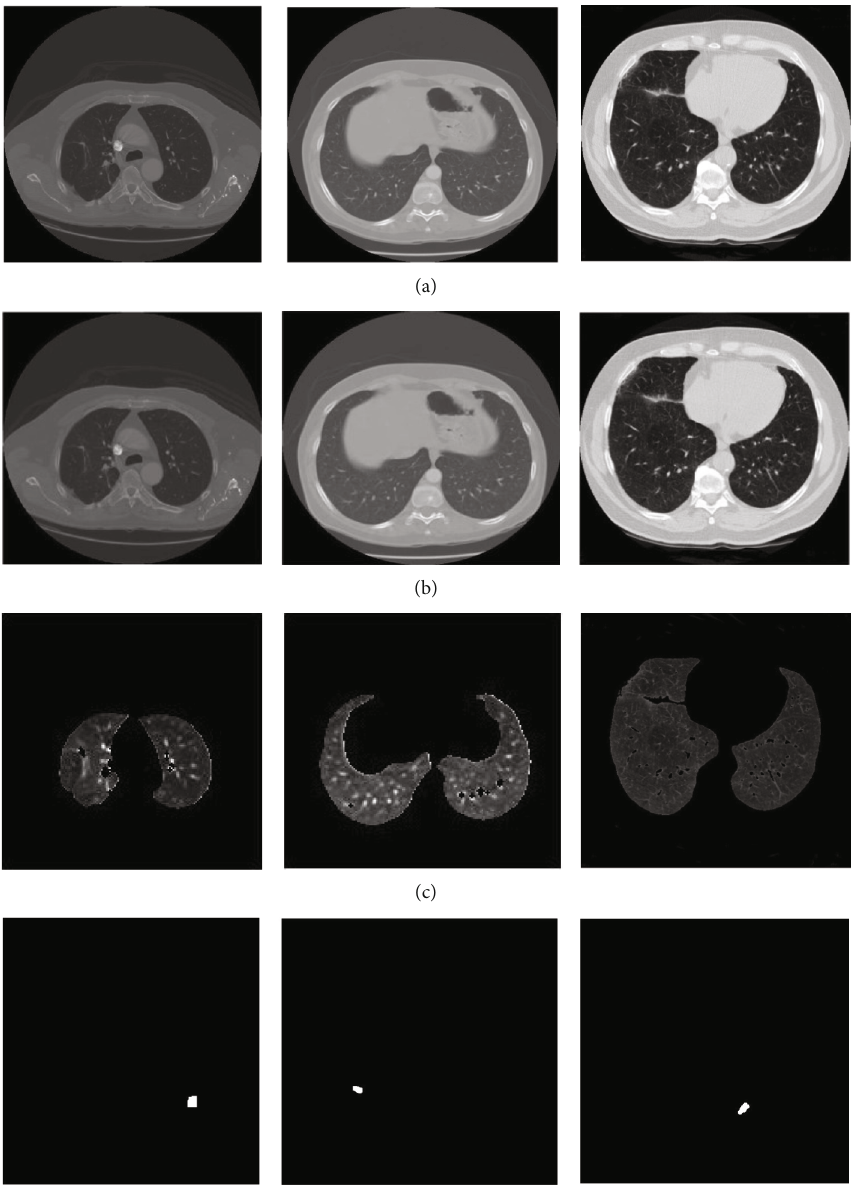
Figure 2: Segmentation results of the proposed method: (a) input images, (b) preprocessed images, (c) lung lobes region segmentation, and (d) lung cancer